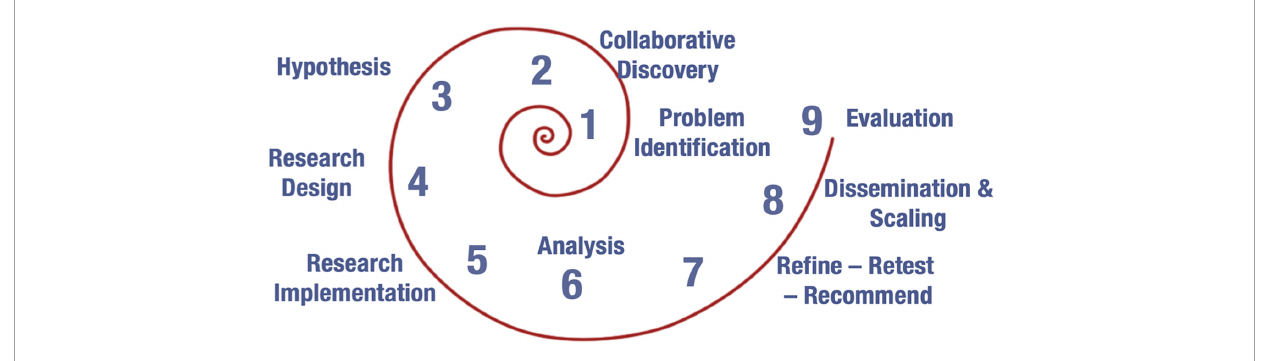
FIGURE1 The impact thinking